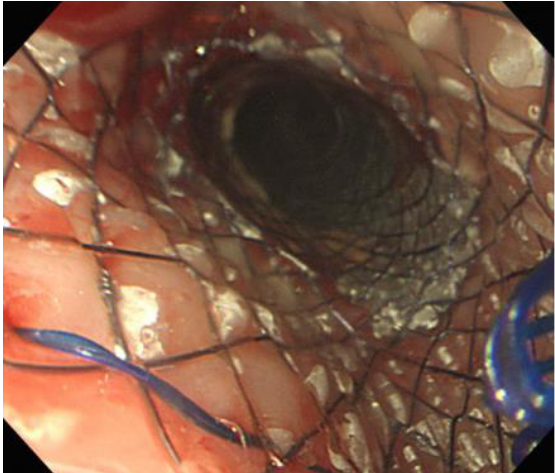
Figure 1. An additional esophageal self-expanding metal stent was inserted over the previously inserted stent due to the development of a tracheoesophageal fistula.